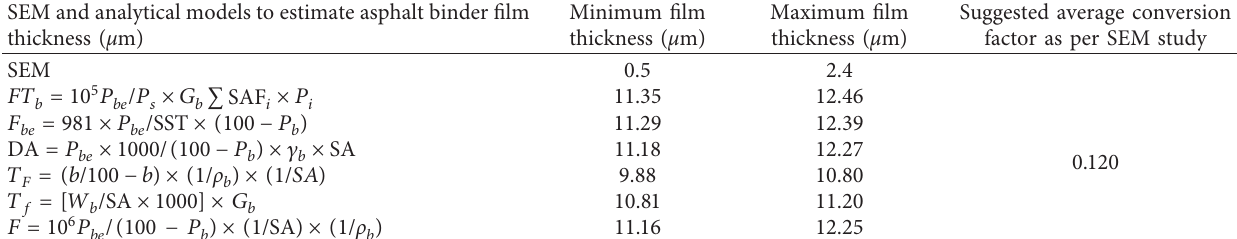
Table 10: Comparison of film thicknesses and suggested average conversion factors based on SEM